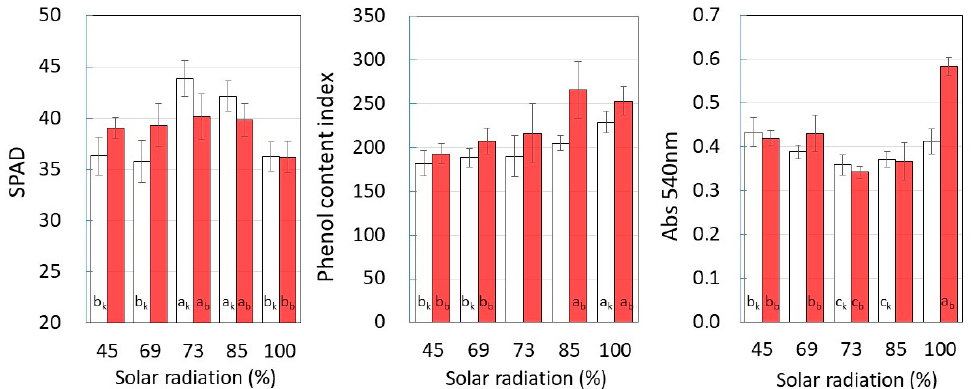
Figure 4. Chlorophyll content (SPAD), total phenol content index, and 540 nm absorbance of the leaf extract in each solar radiation rate. Symbols: □ ; Suikenkintoki , ■ ; Beniharuka . Data are the means and error bars represent the standard error of the mean. Different letters indicate statistically significant differences between cultivation layers ( p < 0.05).